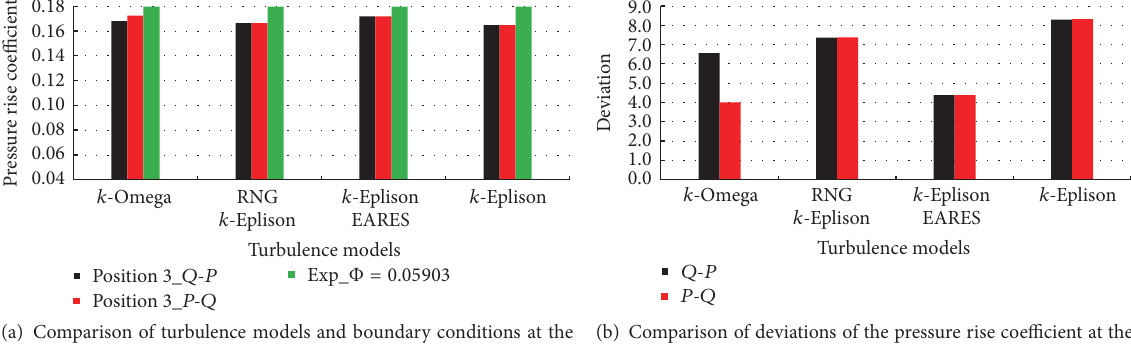
(b) Comparison of deviations of the pressure rise coefficient at the flow coefficient of B = 0.05903